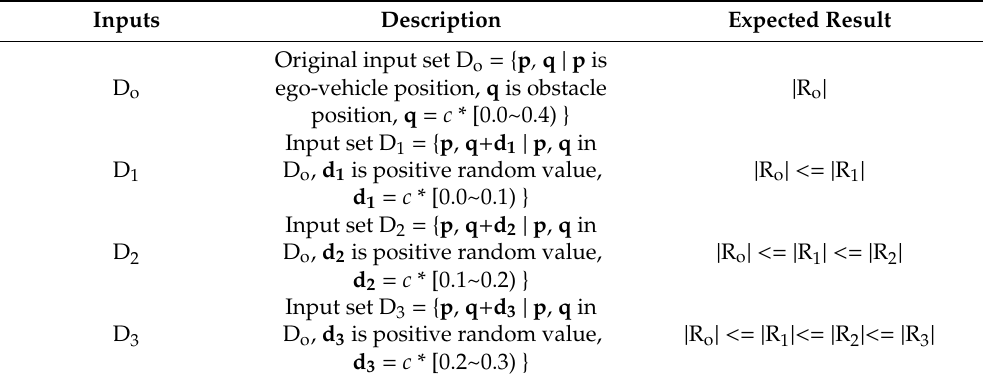
Figure 15. (a) Avoidance test setup and two scenarios of the test: (b) Bypass with a min. margin vs. (c) Blocked.